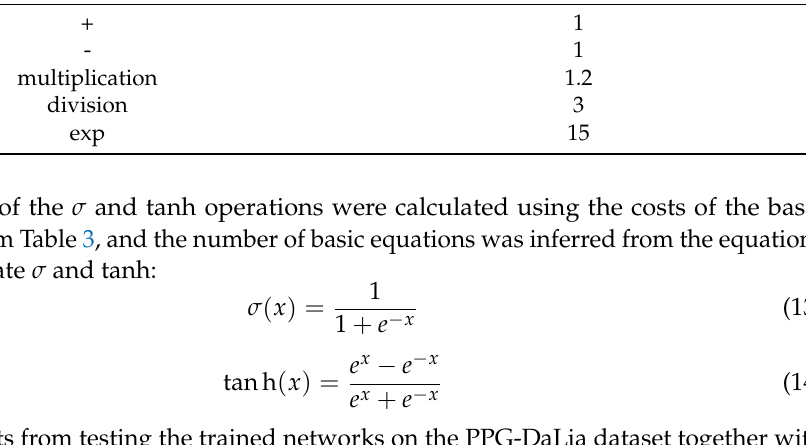
Figure 12. Example of PPG signals before and after processing with the trained LSTM network ( a ) and example of input acceleration signals ( b ). For this example, the following network variant was used: L = 4, S = 2 N h = 32, N l = 1 with the input waveforms from the validation dataset. Table 2. Comparison of the accuracy of the 5 most promising variants of the solution presented in this paper to the algorithms from the literature on the large PPG-DaLia dataset as MAE (bpm). The heart rate measurements were recorded every 2 s. Each LSTM network was trained for 60 epochs on the training dataset described in Section 3 of this paper. All system. The results are presented in Table 3. Table 3. Estimated computational costs of basic operations, normalised to the cost of the ‘+’ operation. The costs were calculated by running the basic maths operations multiple times in the C software (compiled without optimisations) on Xilinx’s Zynq platform with an Arm processor and Ubuntu Linux and measuring the execution time. Approximate Computational Cost (Relative Operation to the Cost of the ‘+’